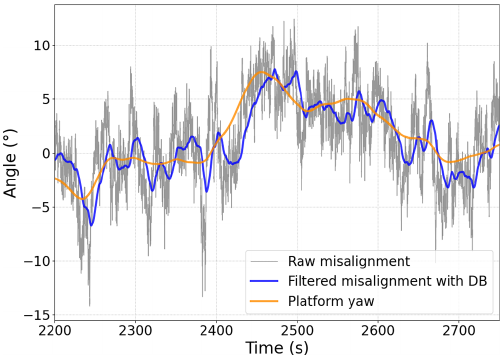
Figure 8. Comparison between raw misalignment (grey), filtered misalignment with DB (blue) and platform yaw angle